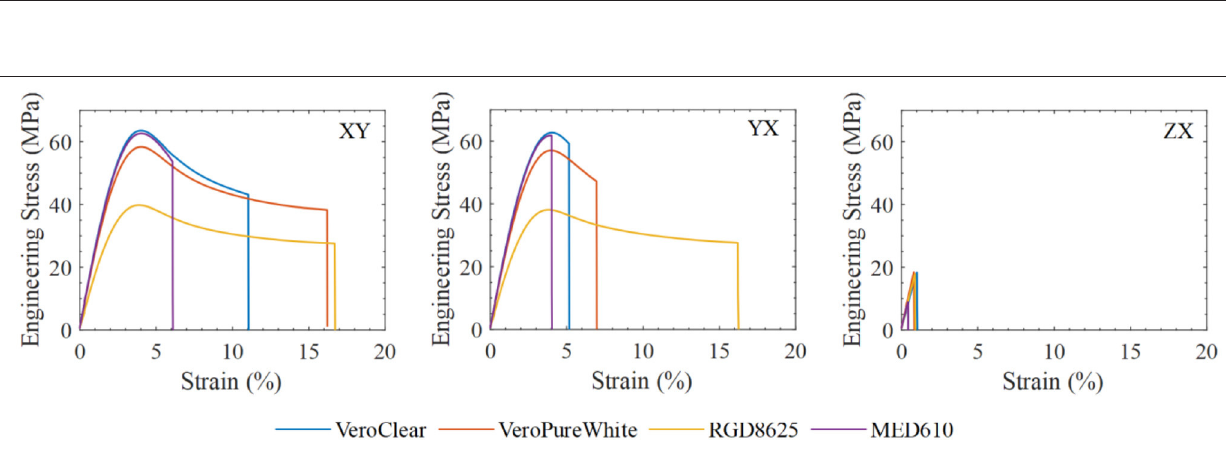
Frontiers in Physics |